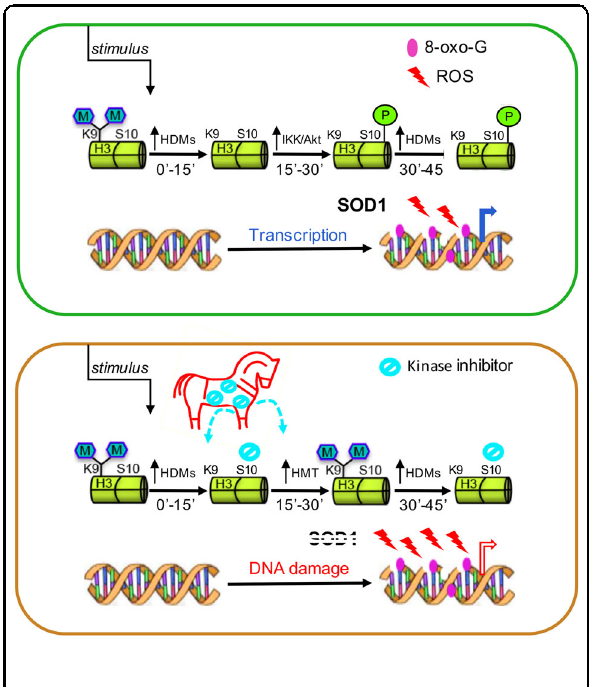
Fig. 3 Role of nuclear ROS in transcription and DNA damage. ROS generated during nuclear receptor-induced transcription of target genes by the activity of lysine demethylases on lysine 9 in histone H3 must be controlled to prevent their accumulation. To this end, SOD1 reaches the nuclear space, while phosphorylation of H3S10 inhibits the rapid remethylation of the same lysine. If inhibitors of the H3S10 kinases are introduced as a Trojan horse together with nuclear receptor ligands, remethylation of H3K9 is quick, nuclear ROS accumulate, and unrepaired DNA damage triggers